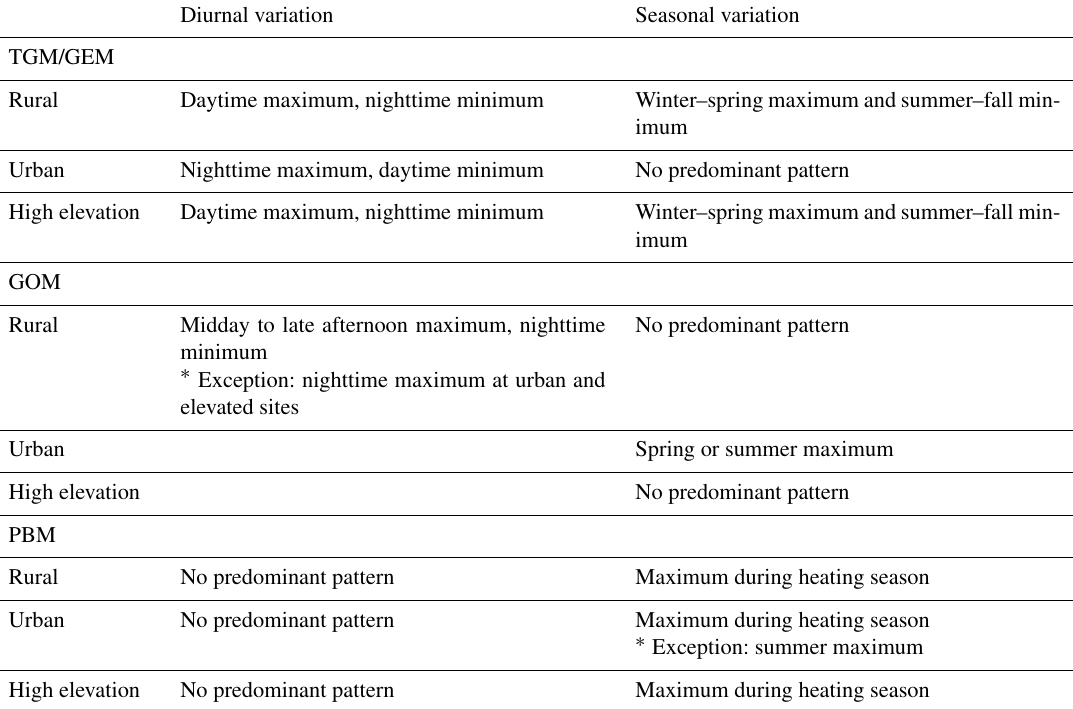
Table 1. Summary of predominant temporal patterns of speciated atmospheric mercury at continental sites in the Northern Hemisphere. Diurnal